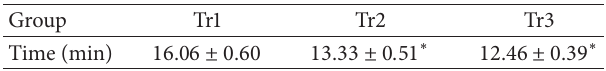
Table 1: Generalised tonic-clonic seizure appearance time (GTC- SAT) in treated group 1 (Tr1, 𝑛 = 15 ), treated group 2 (Tr2, 𝑛 = 10 ), and treated group 3 (Tr3, 𝑛 = 7 ). ∗ 𝑃 < 0.05 versus Tr1.